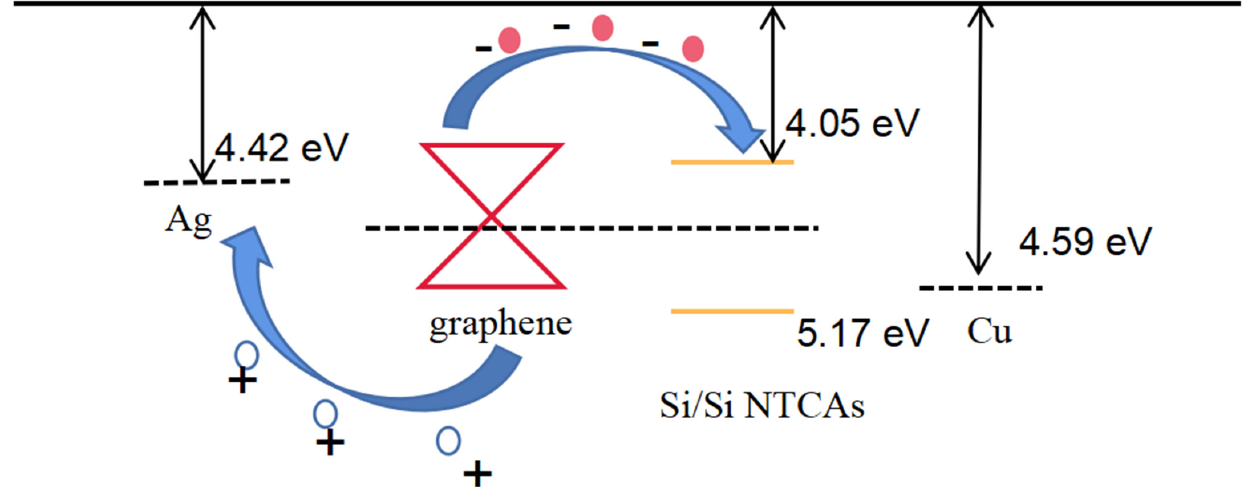
Figure 8. Band diagrams and carrier migration schematics.